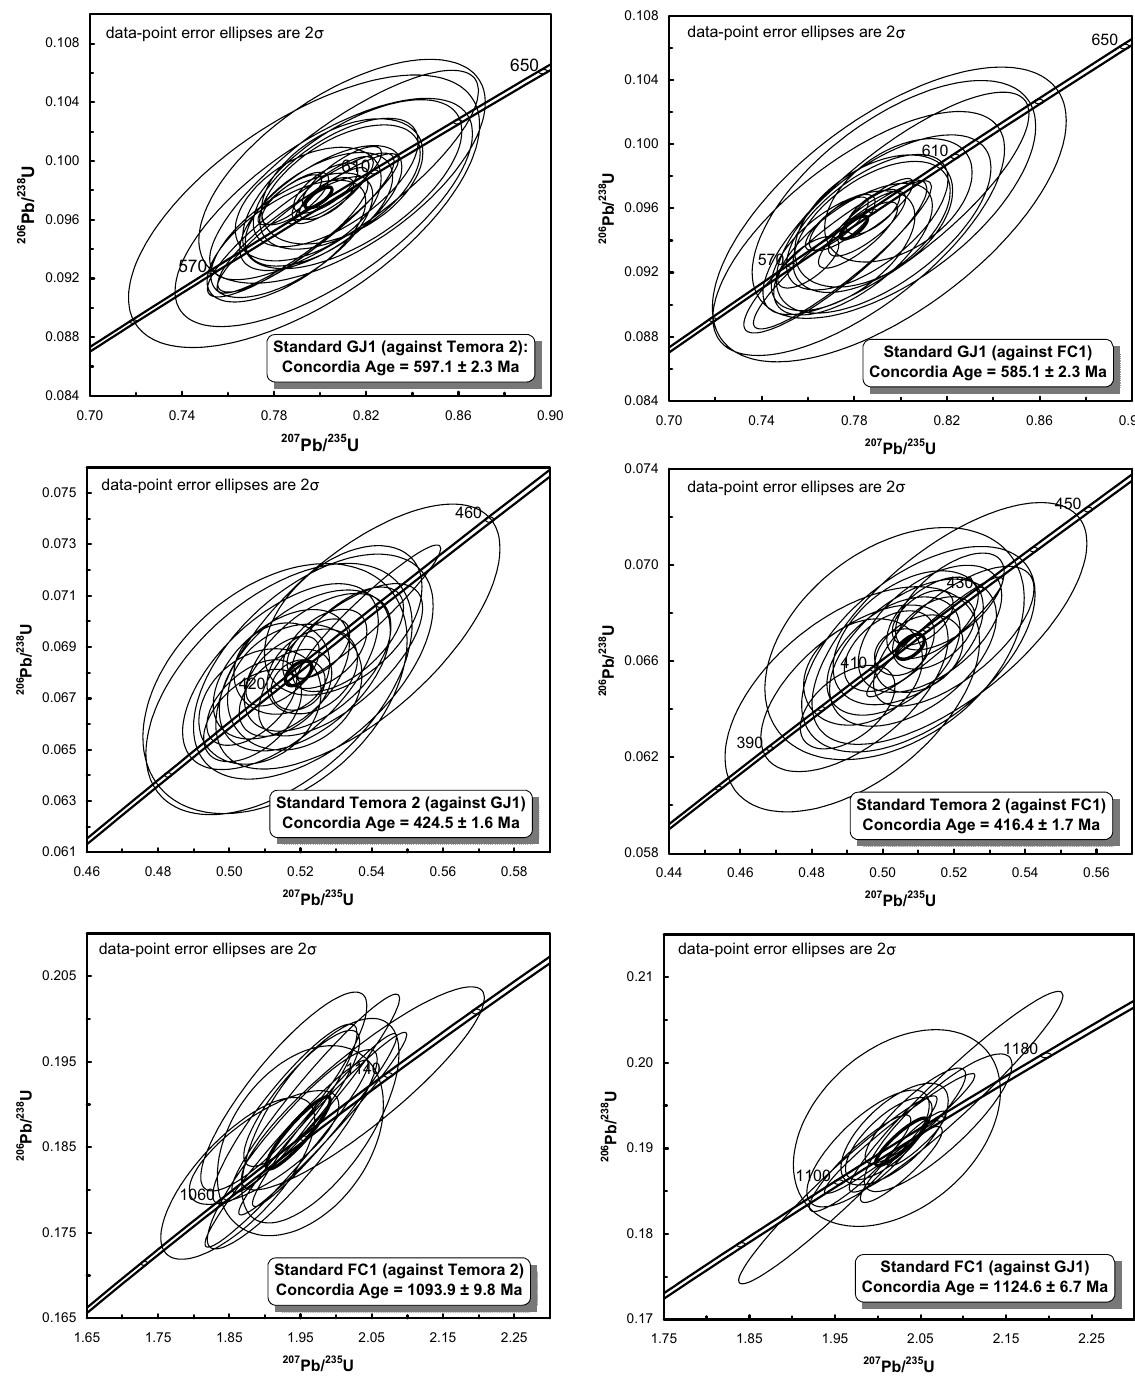
Fig. 4 – Concordia diagrams of LA-ICP-MS analyses of standards GJ1, Temora 2 and FC1. See Table I for the full data set. The Concordia line is shown as a Concordia band considering the 2 σ decay constant errors for 235 U and 238 U of Ludwig